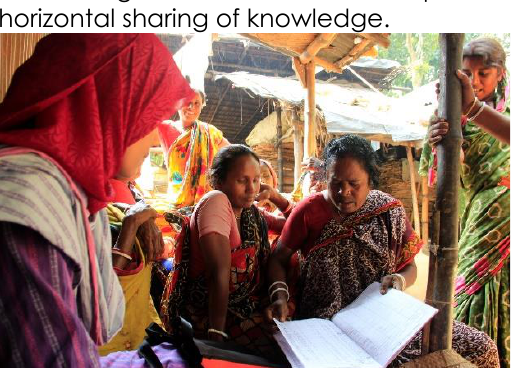
Figure 9: Community leader from Mohishakundu helping with book keeping in Shoshanpara